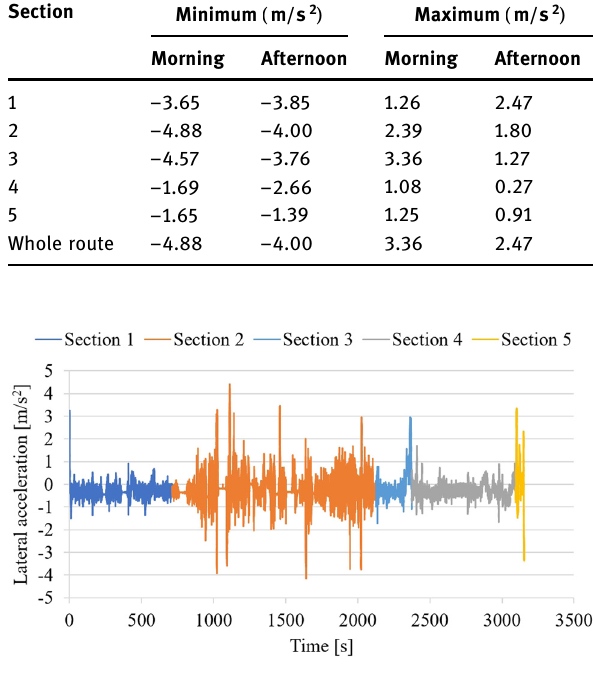
Table 3: List of extreme longitudinal acceleration values Section